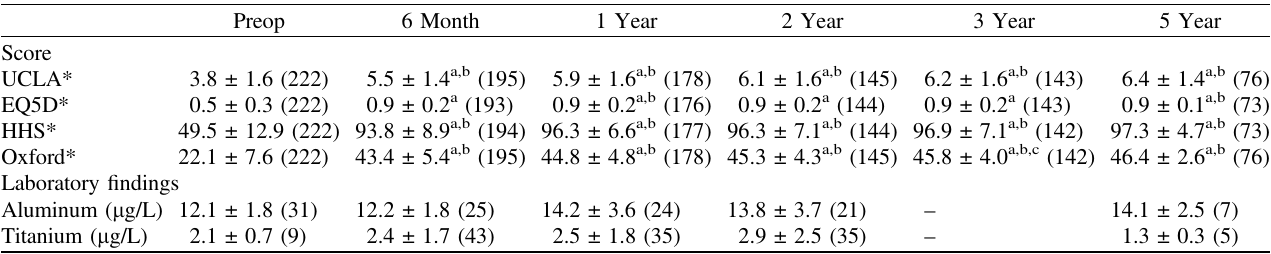
Table 1. Clinical evaluation at each time point. Multicomparison tests were performed with the analysis of variance (ANOVA) test for repeated measures, while difference between time points was performed with Bonferroni adjusted p